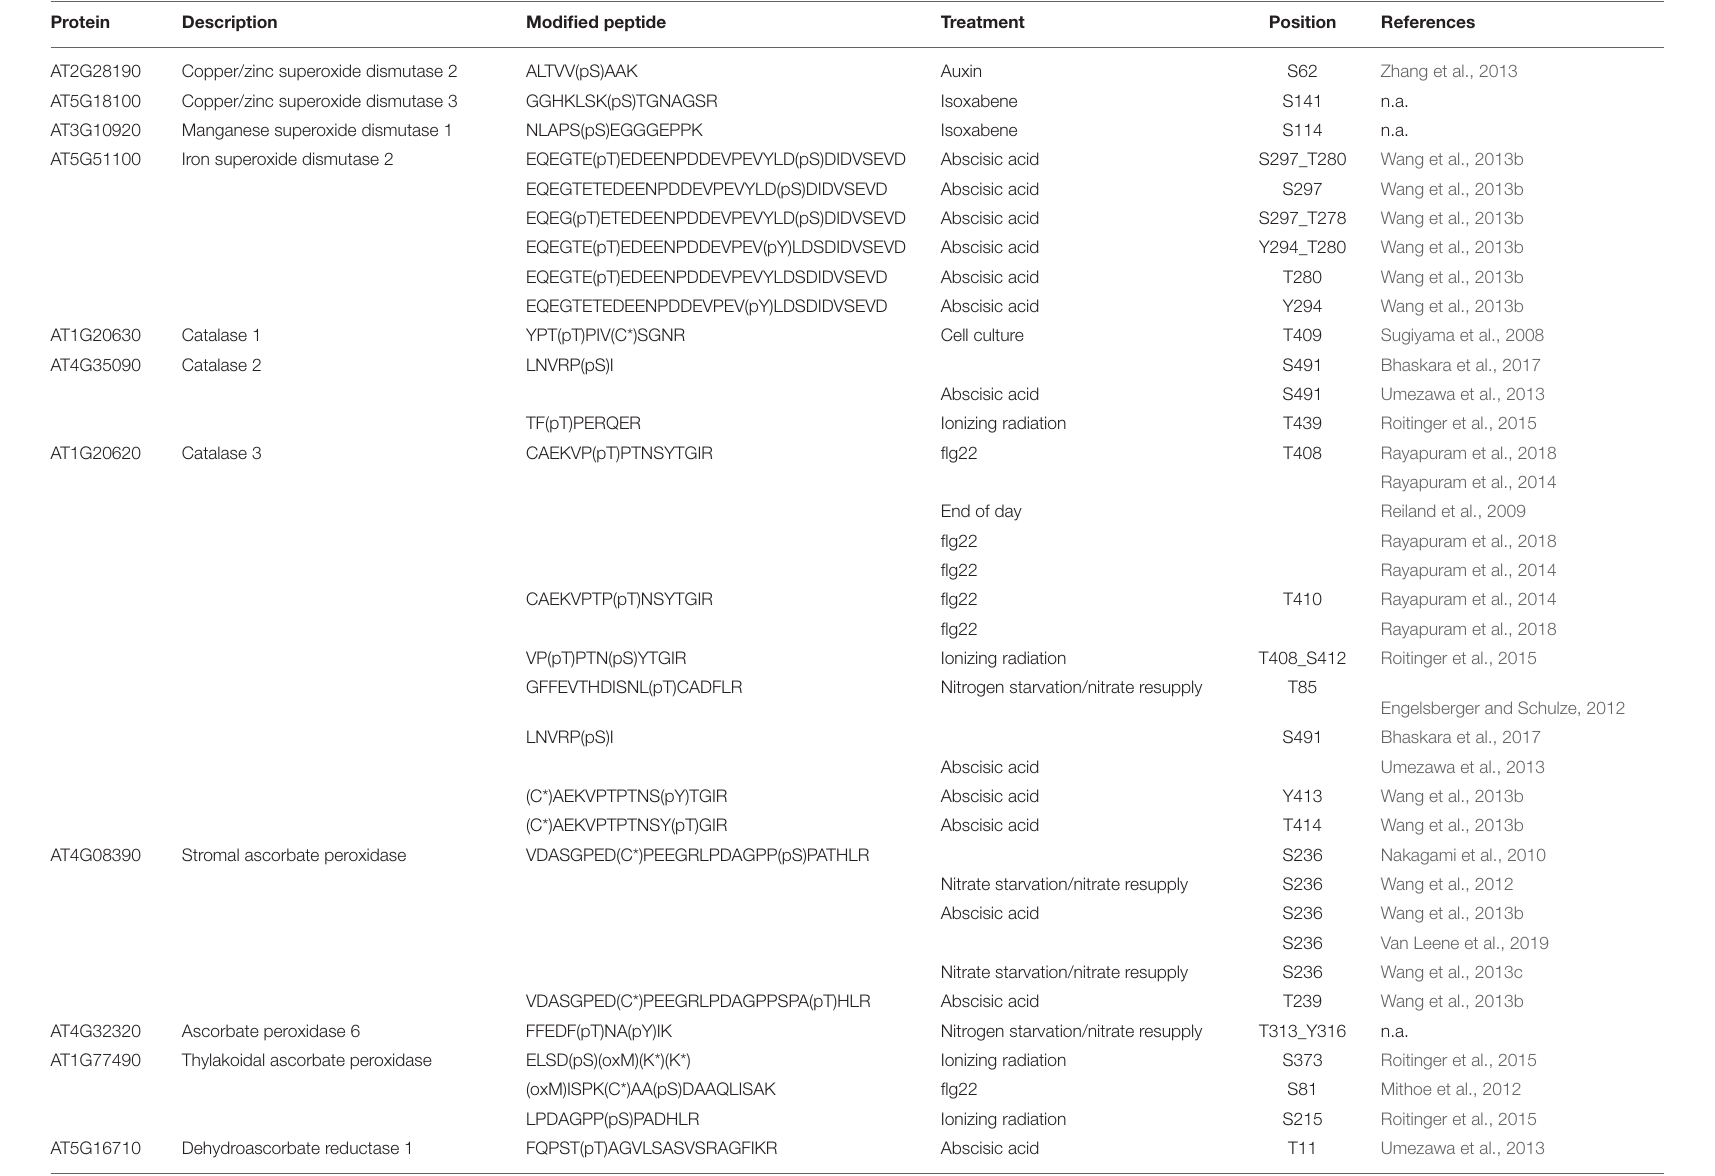
TABLE 1 | Phosphorylation sites experimentally found in antioxidant enzymes by mass spectrometry, retrieved from PhosPhat database.